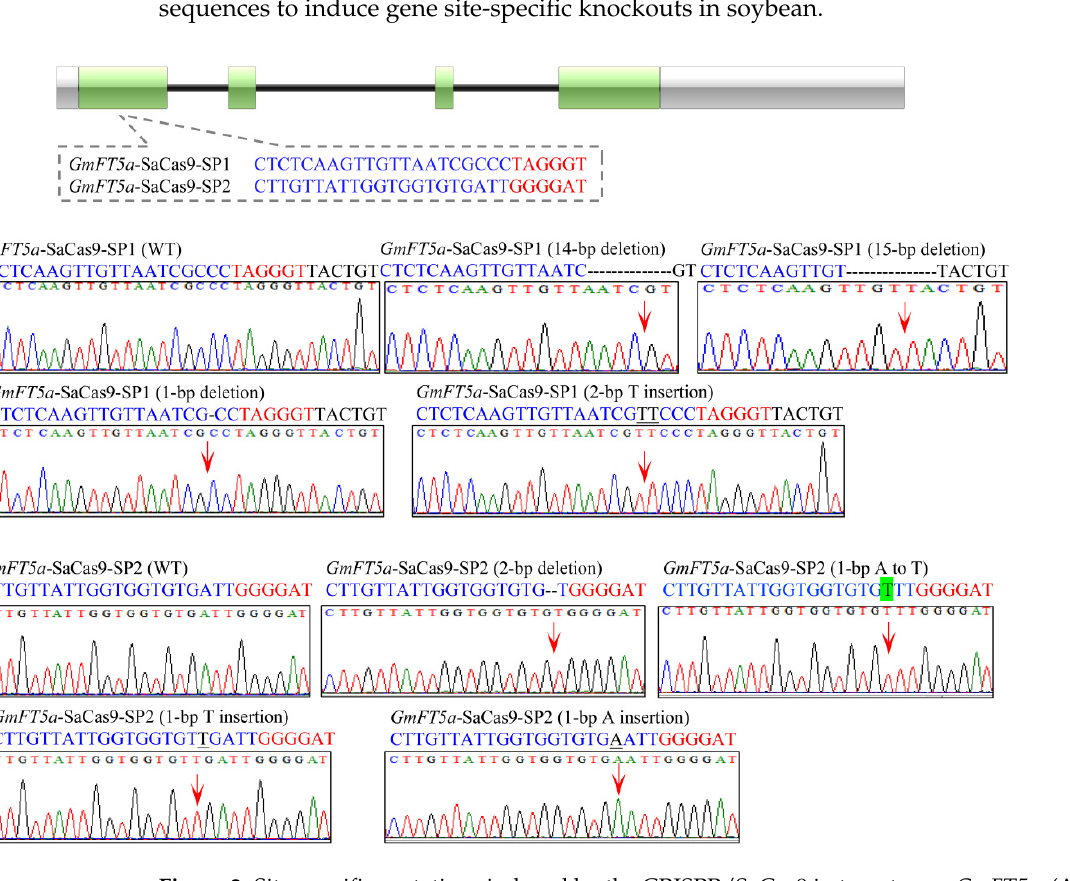
Figure 2. Site-specific mutations induced by the CRISPR/SaCas9 in target gene GmFT5a . ( A ) Gene structures of GmFT5a with two target sites of CRISPR/SaCas9. Green stripe, exon; black solid line, intron; gray stripe, UTR (untranslated region). The red letters are PAM (protospacer adjacent motif) sequences. ( B , C ) Sequences of WT (wild type) and representative mutation types induced at target sites GmFT5a -SaCas9-SP1 and GmFT5a -SaCas9-SP2 are presented, respectively. Underline, insertions. Dashes, deletions. Base substitution is indicated with the capital letter on a green background. The red arrowheads indicate the location of mutations.